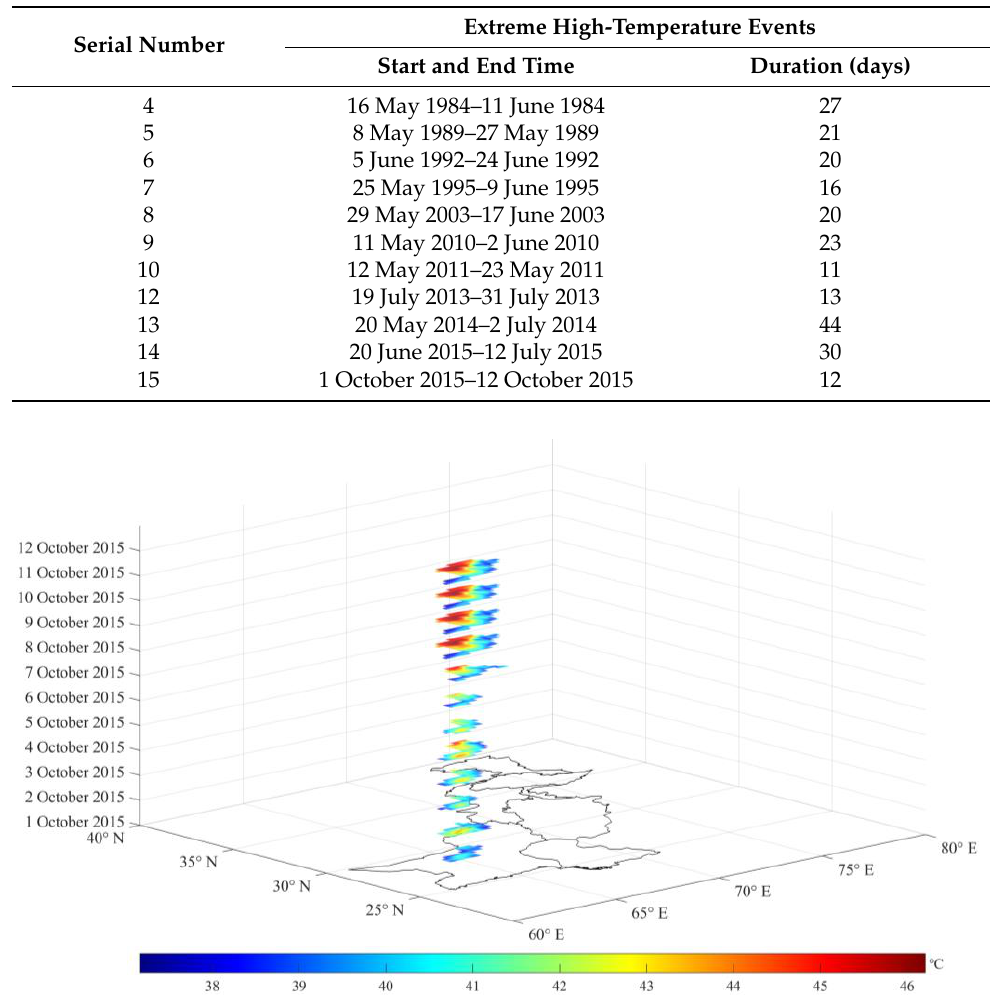
Table 2. Starting and ending time and duration of typical extreme high-temperature events in CPEC